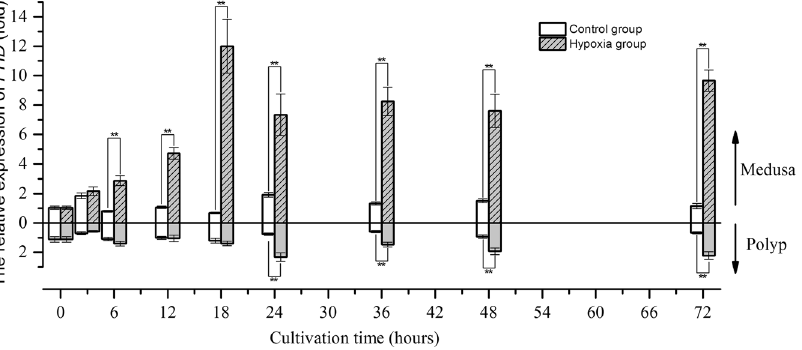
Figure 4. The gene expression variation of PHD in medusa and polyps over time ( * represents p < 0.05 and ** represents p < 0.01; Error bar is standard error).